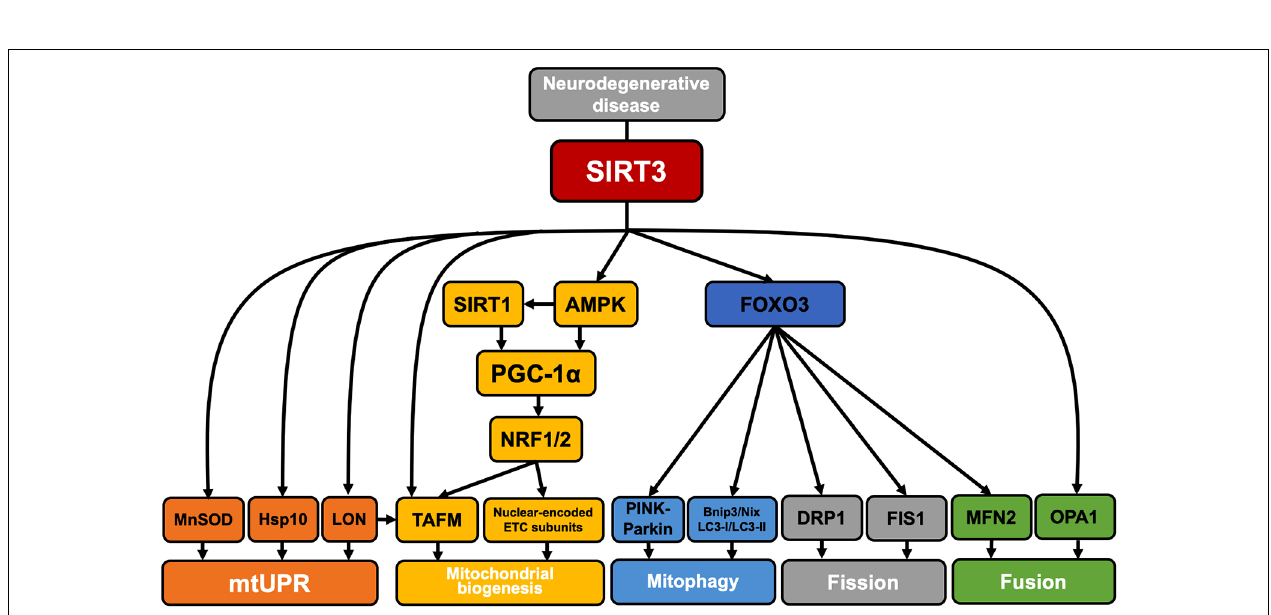
FIGURE 3 | SIRT3 regulation of mitochondrial quality control in neurodegenerative disease. SIRT3 is involved in the regulation of mitochondrial quality control in neurodegenerative diseases. SIRT3 deacetylates MnSOD, HSP10, and Lon proteases and participates in the mitochondrial unfolded protein response. SIRT3 can activate AMPK by upregulating the ratio of AMP/ATP. Activated AMPK can directly phosphorylate PGC-1 α or enhance SIRT1 activity by increasing NAD+ levels, and SIRT1 can then deacetylate PGC-1 α . PGC-1 α interacts with NRF1/2 to activate TFAM and promote the synthesis and import of nuclear-encoded ETC complex subunits [such as the Fe–S subunit of succinate dehydrogenase (SDH) or the subunit of cytochrome c oxidase]. In addition, Lon proteases are also involved in the selective degradation of TFAM to regulate mitochondrial biogenesis. SIRT3 can deacetylate FOXO3, thereby activating PINK1–Parkin pathway-mediated mitophagy. Activated FOXO3 also promotes the expression of Bnip3/Nix, LC3-I/LC3-II, DRP1, FIS1, and MNF2 and regulates mitophagy and mitochondrial fission/fusion. The direct deacetylation of OPA1 by SIRT3 is also involved in the regulation of mitochondrial fusion.